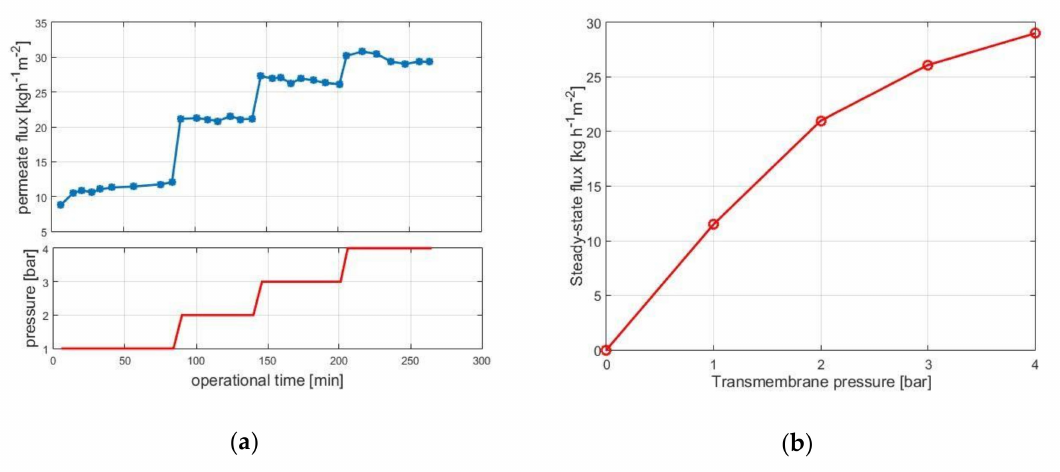
Figure 2. Permeate flux as function of operational time for various transmembrane pressures ( a ) and quasi steady-state flux values versus pressure ( b ). Operational conditions: 30 w / w % lactose concentration, 10 g · kg − 1 enzyme load, pH 6.0, 50 ◦ C, 0.18 m 3 · h − 1 crossflow rate, 10 kDa UF